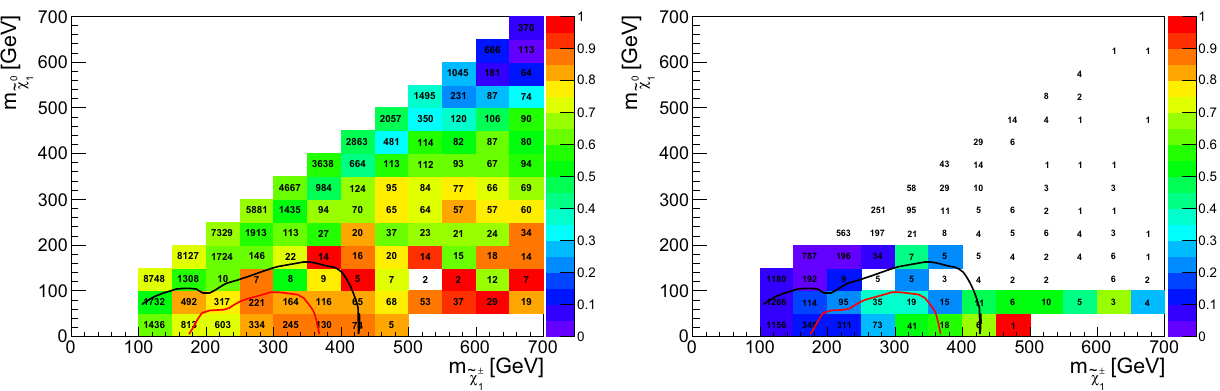
are combined. Gray points have BR < 10% for the decays considered. The black lines are the 95% CL exclusion lines for the ˜ t 1 → t ˜ χ 0 plified model from [45] (left) and the ˜ b 1 → b ˜ χ 0 [49] (right). See text for details Fraction of Bino+Higgsino LSP ATLAS EW excluded points excluded by SModelS EW